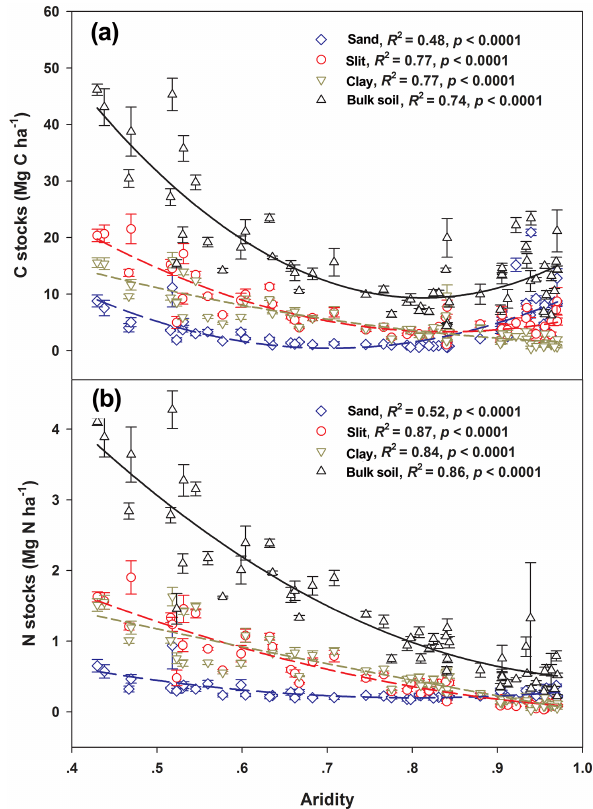
Figure 2. Carbon (a) and N concentrations (b) in all of the three particle–size fractions, as well as in bulk soils, were negatively cor- related with increasing aridity. Data are presented as mean ± 1SE ( n = 5).